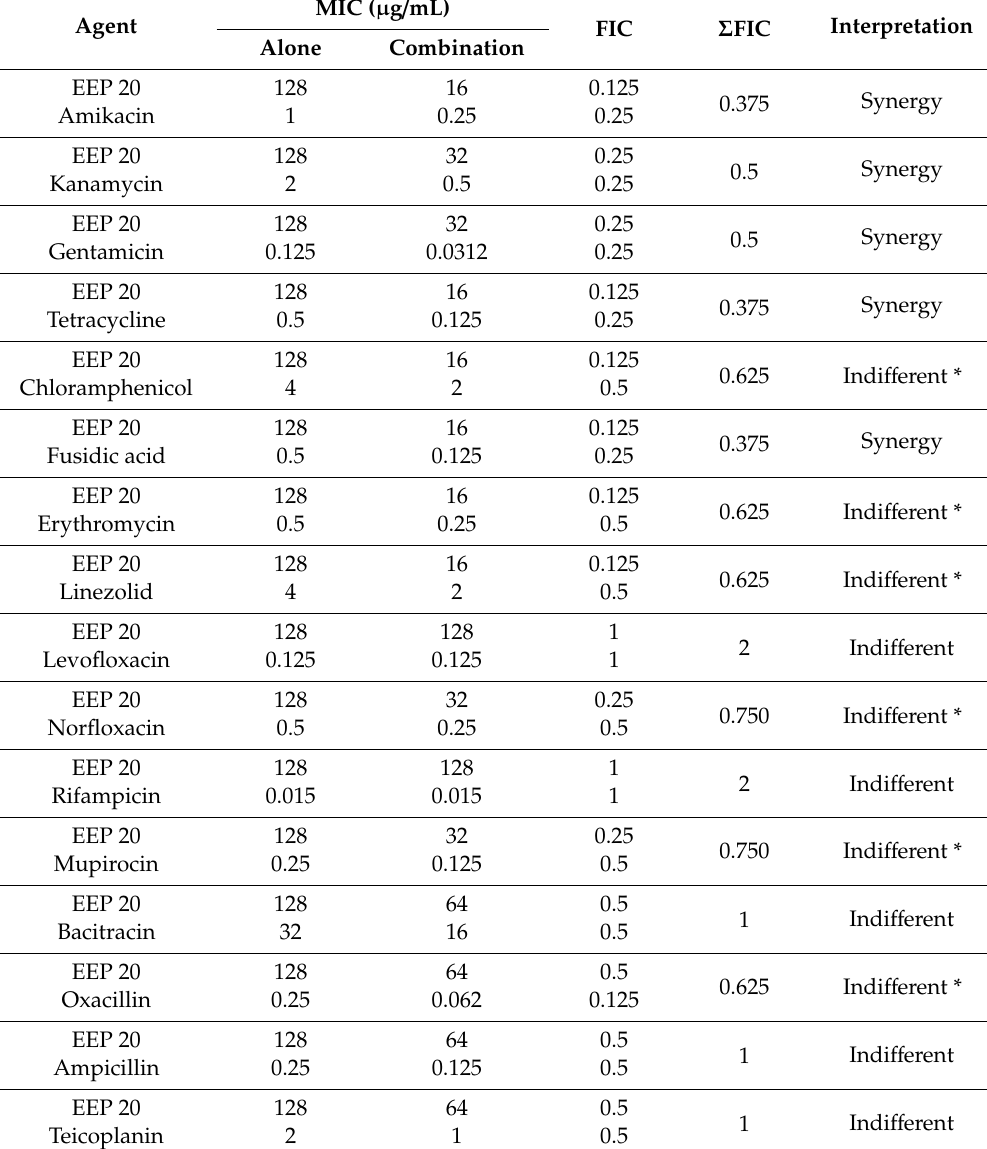
Table 3. The results of checkerboard analysis of drug interaction between EEP20 and di ff erent antibiotics against S. aureus ATCC